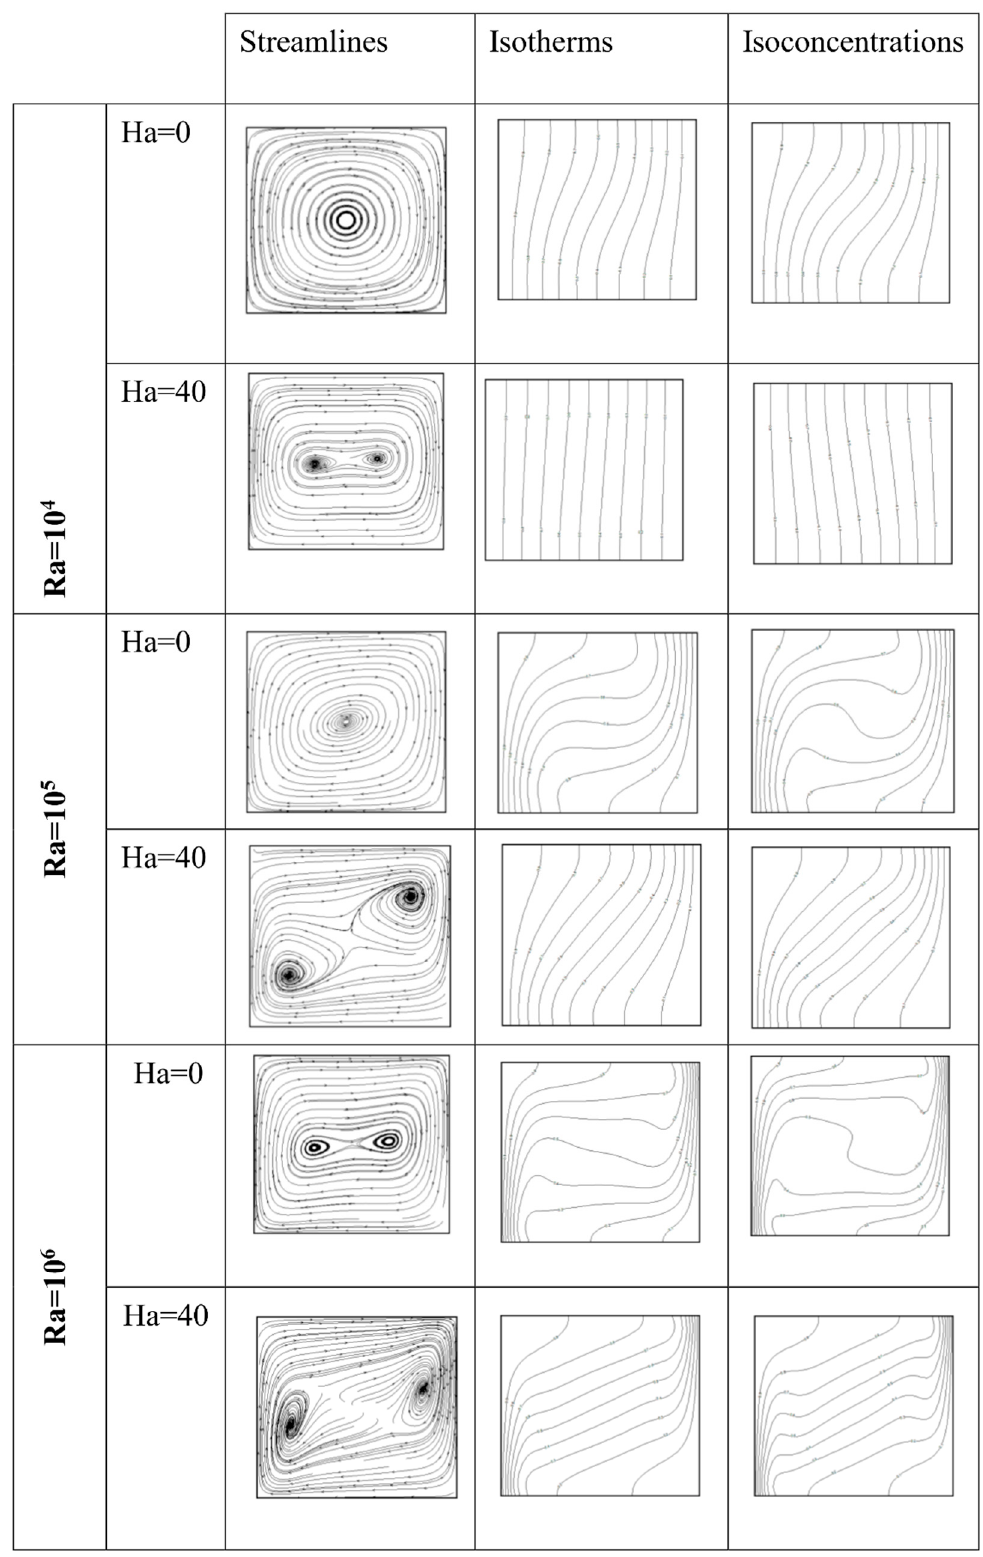
Figure 9. Projections of flow lines, isotherms and isoconcentrations in the main plane Z = 0.5 for various values Rayleigh number and Hartmann number with φ = 4%, K = 1, N = − 0.5, Pr = 6.2 and Le = 1.